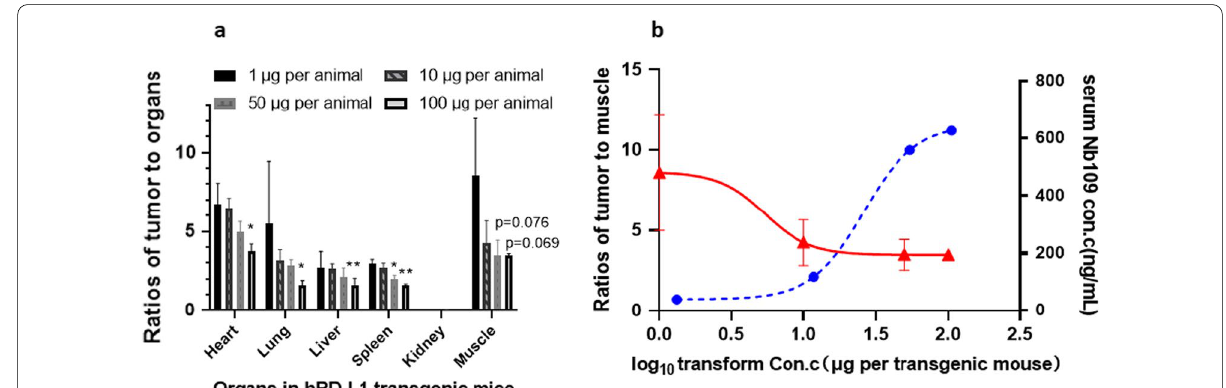
Fig. 2 a Tumor-to-organ ratios for different masses of 68 Ga-NOTA-Nb109 in C57-hPD-L1 transgenic MC38-hPD-L1 tumor-bearing mice ( n 90 min after the tracers injection. b Fitting curves of tumor-to-muscle ratios or serum Nb109 concentration (** P < 0.01, * P < 0.05). P values were calculated vs. 1 μg group by a two-sided